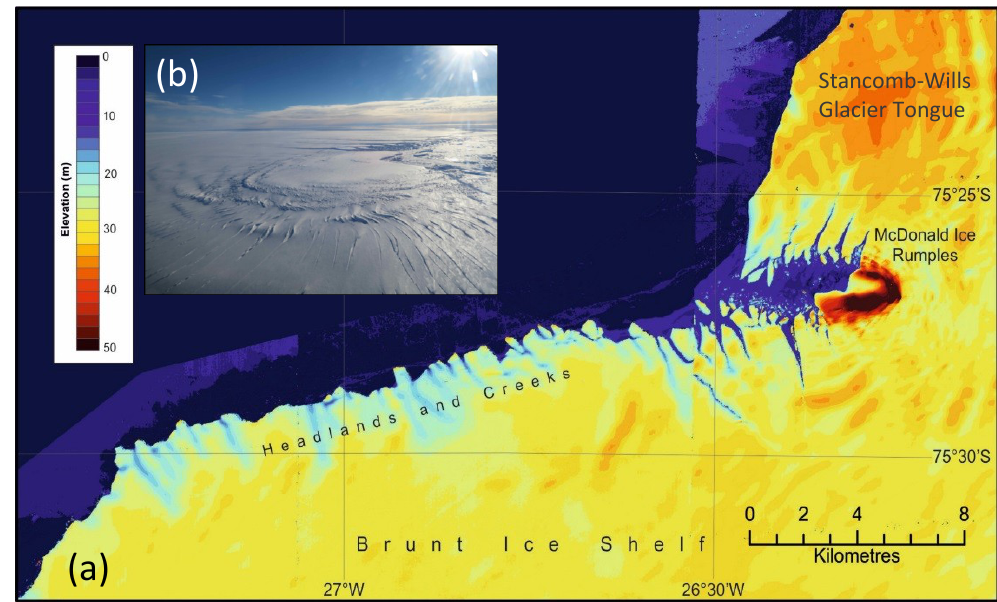
Figure 10. (a) Surface altimetry of the north-eastern part of the Brunt Ice Shelf and the McDonald Ice Rumples showing the deformation of the ice shelf where it is deflected around the McDonald Bank (Fig. 5). (b) An oblique aerial photograph of the McDonald Ice Rumples in 2017, facing NNW (credit: Jan de Rydt,